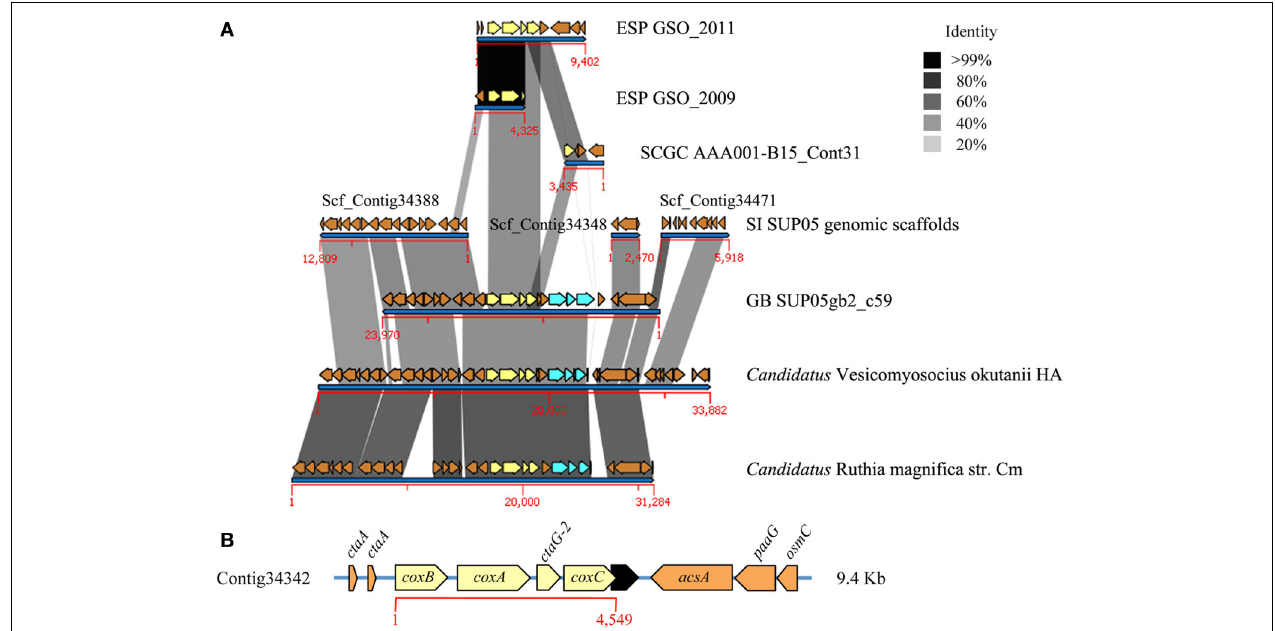
FIGURE 5 | Complexes IV of the oxidative phosphorylation pathway in the ESP-GSO lineage off coast of Concepcion. In (A) are shown de novo contigs constructed with metagenomic sequences from 2009 and 2011 sampling, compared against contigs from the uncultured SI SUP05 and GB SUP05 cluster bacterium, ARCTIC96BD-19 strain AAA001-B15 and the reference symbionts genomes Candidatus Ruthia magnifica and Candidatus